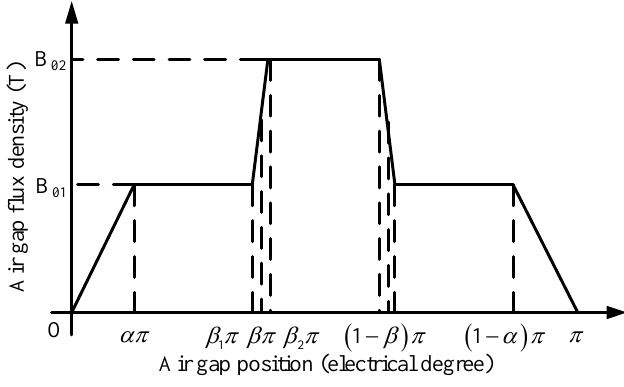
Figure 10. Improved air gap flux density waveform at no-load.